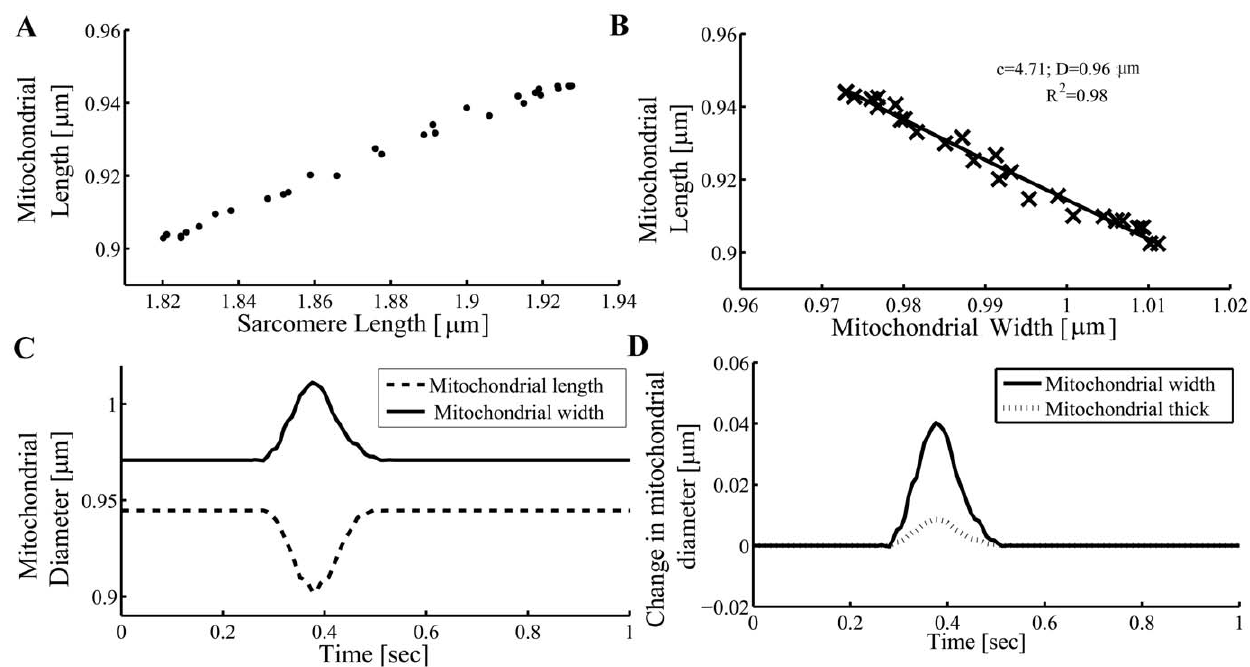
Figure 5. Sarcomere-mitochondrial length and mitochondrial length-width relationships during cardiomyocyte contraction- relaxation cycle. The relationship between mitochondrial length and (A) sarcomere length or (B) mitochondrial width. c is the coefficient of anisotropy (ratio of deformation magnitude between the width-y and thick-z axes) and D is the average mitochondrial diameter. (C) Mitochondrial length and width vs. time during a single contraction cycle. (D) Change in mitochondrial width and calculated thickness vs. time during a single contraction cycle. Data shown is from a representative single cardiomyocyte experiment.